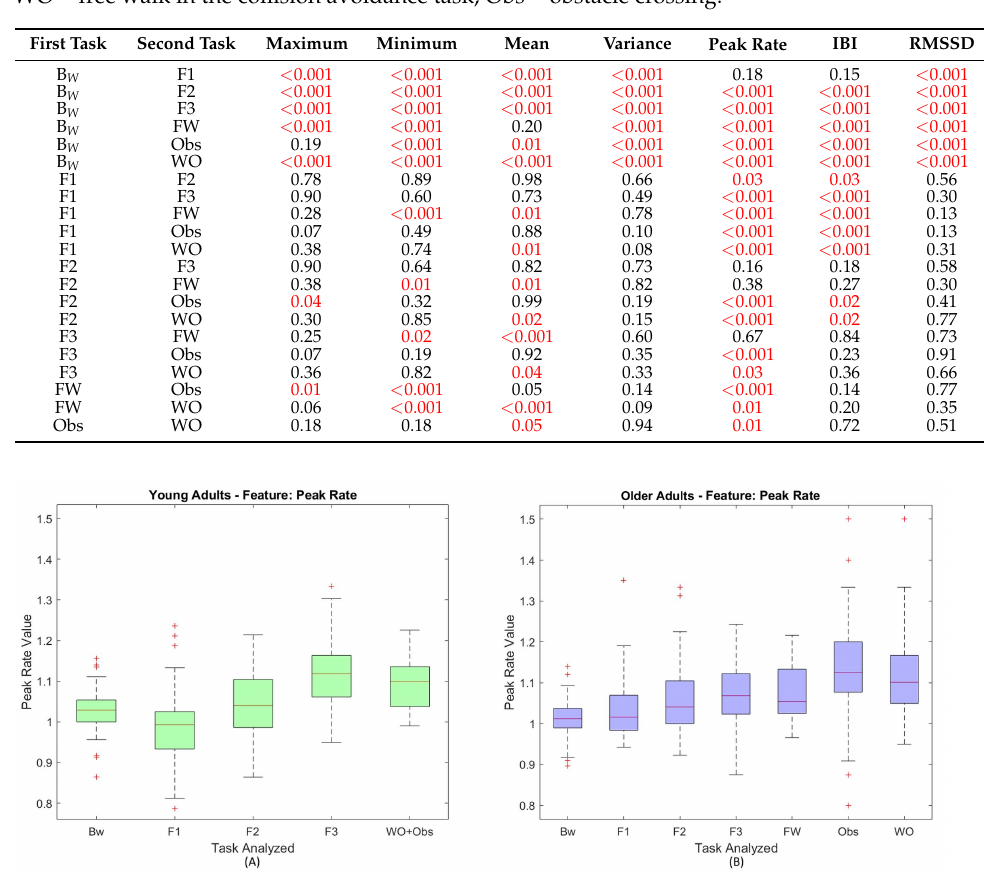
Figure 4. Boxplots of the peak rate in the different tasks. The left boxplot in green ( A ) refers to the young adults while the right one in blue ( B ) refers to the older adults. For each box, the outliers are marked using the ’+’